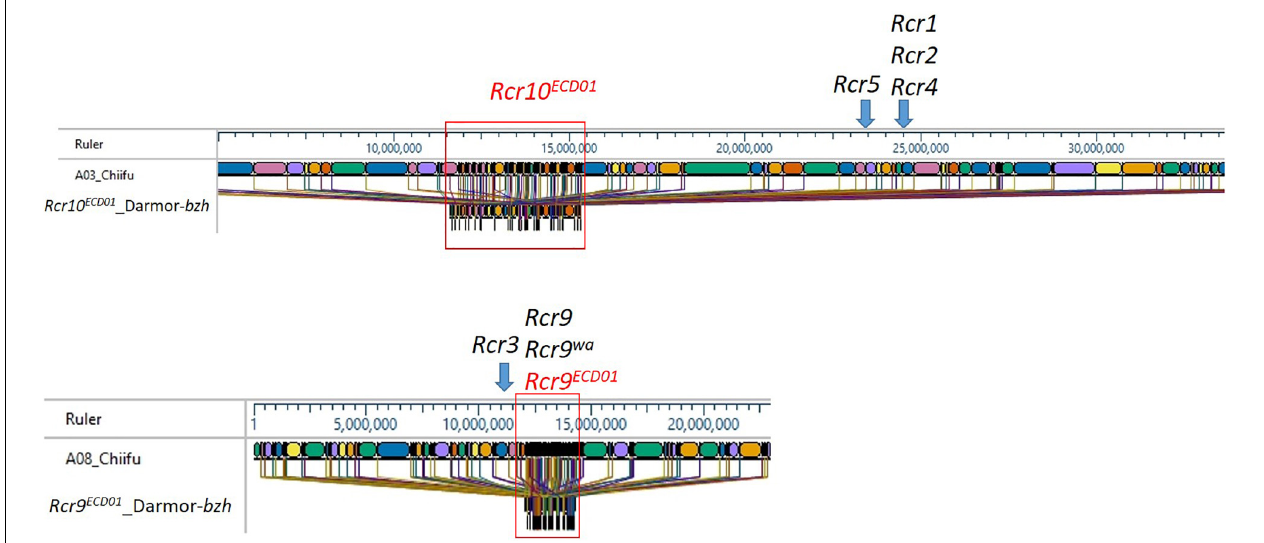
FIGURE 5 | Maps of the Rcr10 ECD 01 and Rcr9 ECD 01 target regions in A03 and A08 of B. napus “Darmor” and the homologous regions of the B. rapa reference genome “Chiifu” version 3.0. Different colors represent the sequenced region of the B. rapa reference genome “Chiifu” version